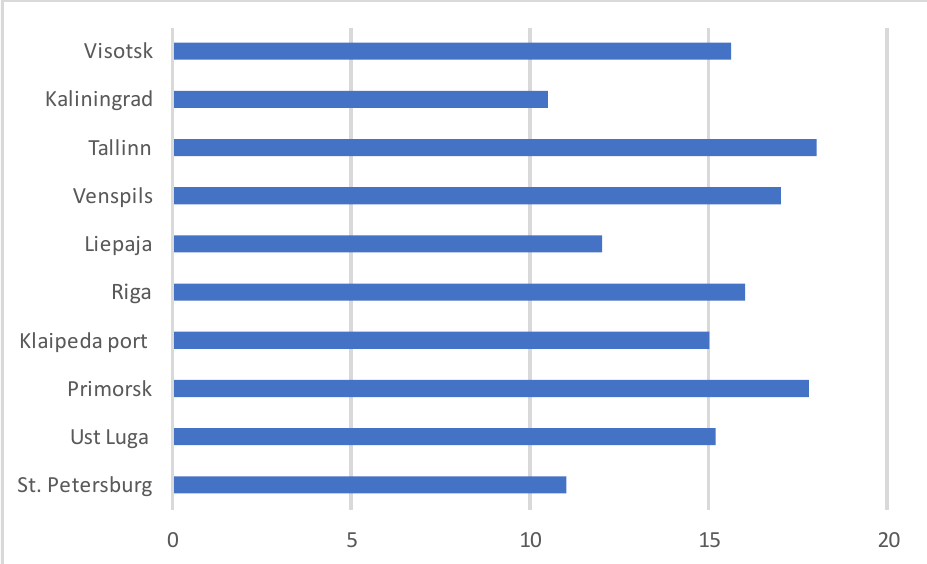
Figure 14. Maximum port depth (meters).